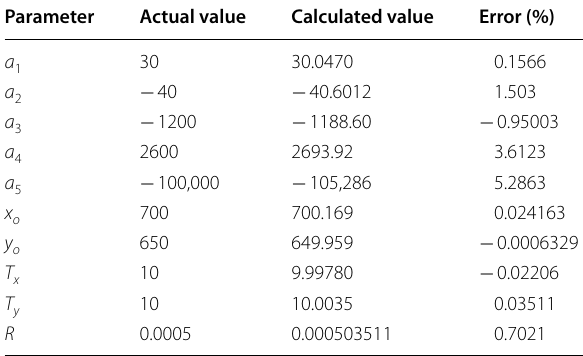
Table 2 Calculation results and relative errors of numerical